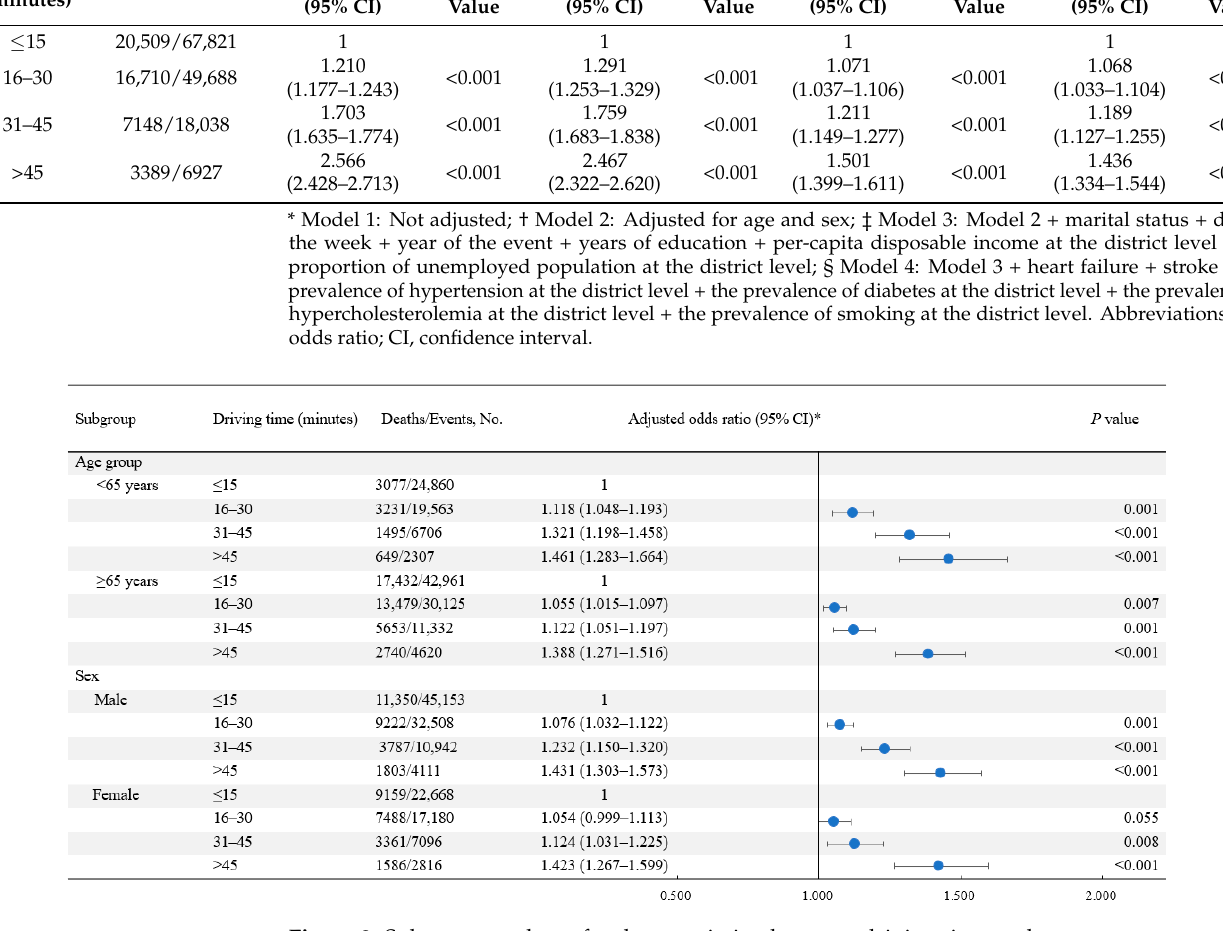
Figure 2. Subgroup analyses for the association between driving time to the nearest percutaneous coronary intervention-capable hospital and the risk of case fatality among patients with acute my- ocardial infarction. * Model adjusted for age, sex, marital status, day of the week, year of the event, heart failure, stroke, years of education, per-capita disposable income at the district level, proportion of unemployed at the district level, prevalence of hypertension at the district level, prevalence of diabetes at the district level, prevalence of hypercholesterolemia at the district level, and prevalence of smoking at the district level. Abbreviations: CI, confidence